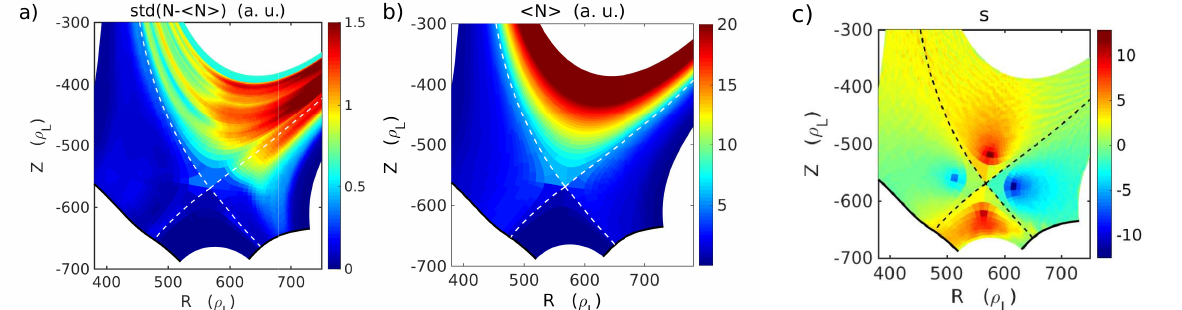
Figure 4. ( a ) Standard deviation of density fluctuations sampled in time and toroidal direction, zoom on the divertor region. ( b ) Poloidal map of the average density. ( c ) 2D map of the local magnetic shear in the divertor